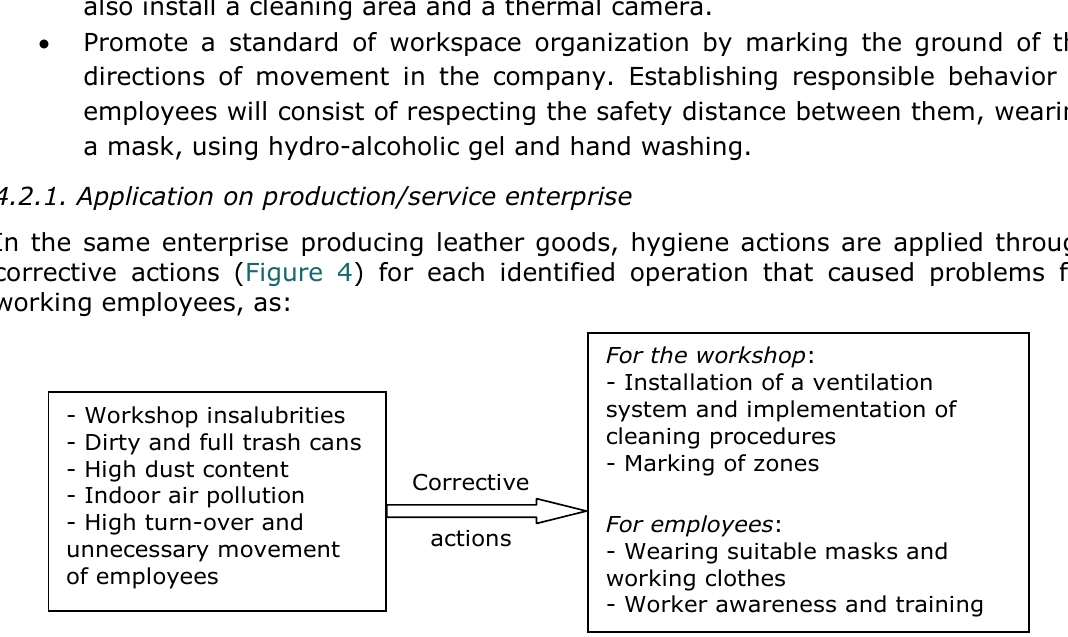
Figure 4. Hygiene actions in production